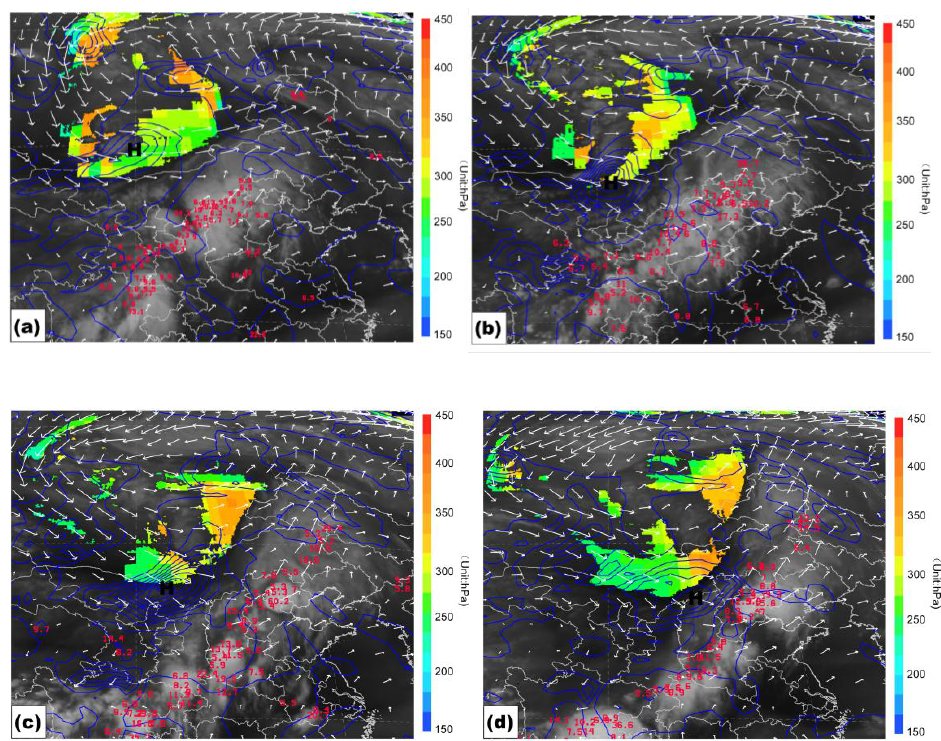
Figure 7. Dry intrusion (color shaded) composited by FY2E WV channel images, cold advection (blue thick line) and wind (white vector) at 320 K isentropic and hourly rainfall (over 5 mm, in red digital) ( a ) 0800 LST 21 July; ( b ) 1400 LST 21 July; ( c ) 2000 LST 21 July; ( d ) 0200 LST 22 July 2012.